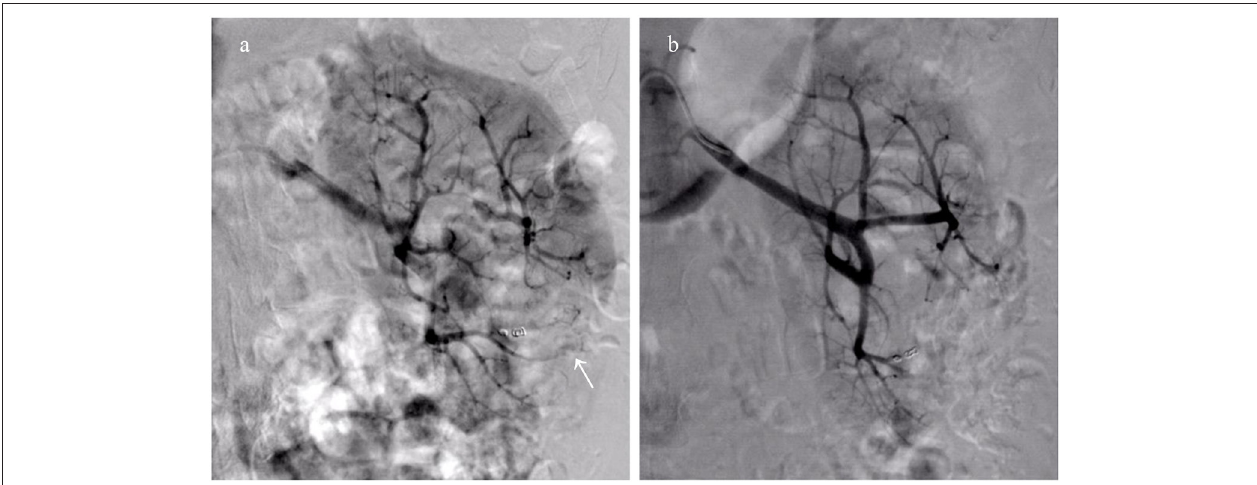
FIGURE 1 | Collateral feeding arteries formed lead to clinical failure after embolization using microcoils alone. (a) Right renal arteriography reveals emerging collateral feeding arteries (white arrow) arising from adjacent artery supply the distal portion of the initial bleeding artery; (b) The hemorrhage disappears following repeat embolization with microspheres (100–300 µ